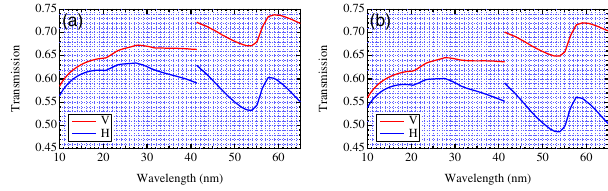
FIG. 3. Simulated transmission for horizontal and vertical polarization as a function of wavelength for the optical transport system to the DiProI (a) and LDM (b) end stations. The step at ≈ 41 . 3 nm (30 eV) is an artifact due to the use of two different data bases [54].